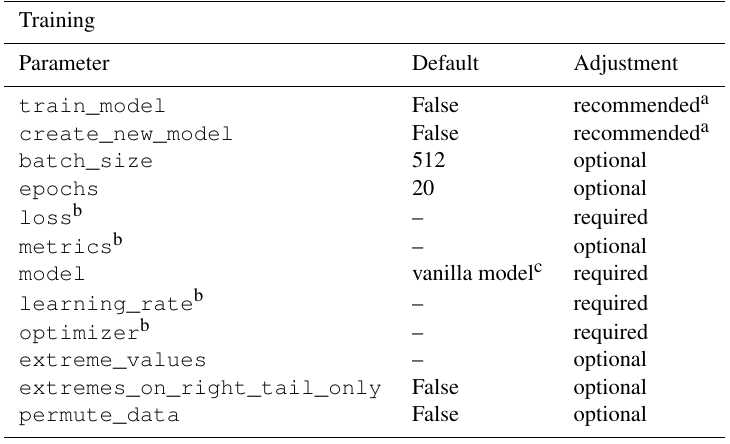
Table 4. Summary of all parameters related to the training that are required, recommended, or optional to adjust for a custom experiment workflow.